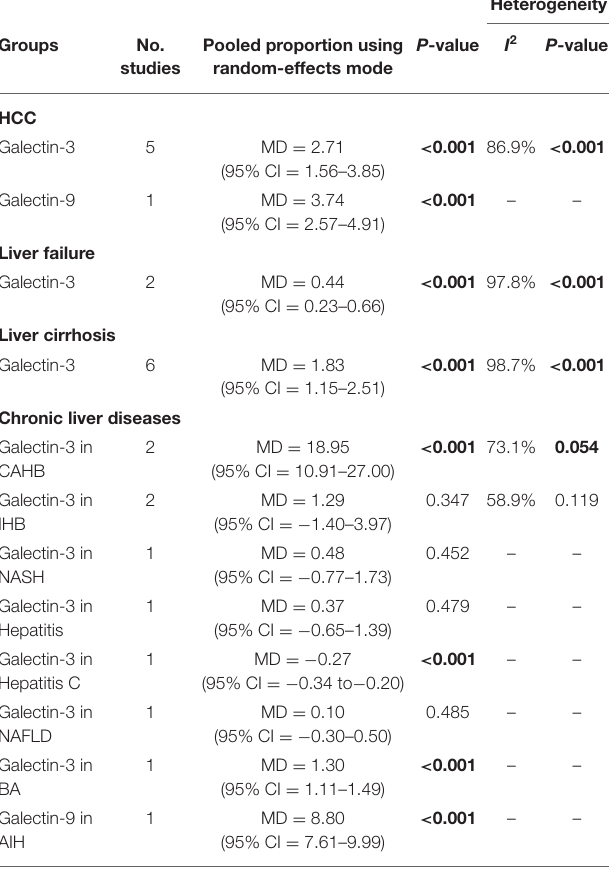
( Figure 2 ). Serum galectin-9 level was significantly higher in the patients with autoimmune hepatitis compared to the healthy